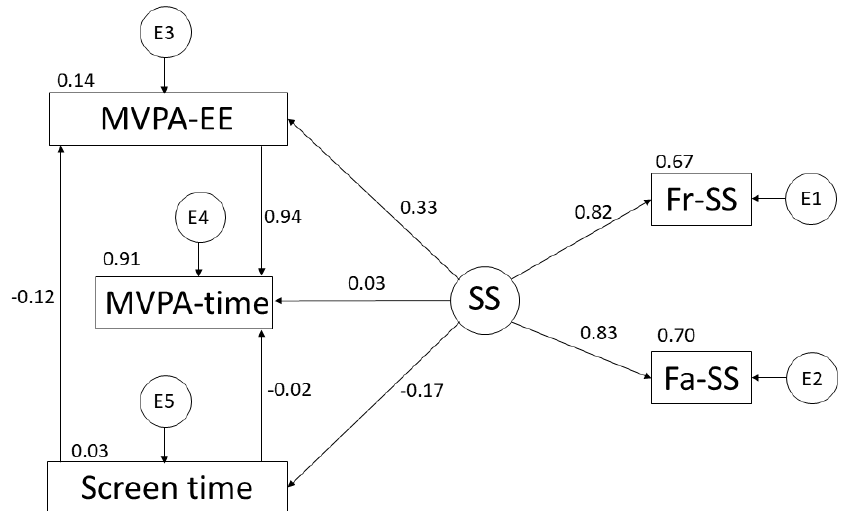
Figure 4. The proposed model in relation to moderate–vigorous physical activity. Moderate–Vigorous Physical Activity Time (MVPA-time); Moderate–Vigorous Physical Activity Energy Expenditure (MVPA-EE); Screen Time (ST); Social Support (SS); Support from Friends (Fr-SS); and Support from Family (Fa-SS). Table 2. The model developed for moderate–vigorous physical activity. Associations between